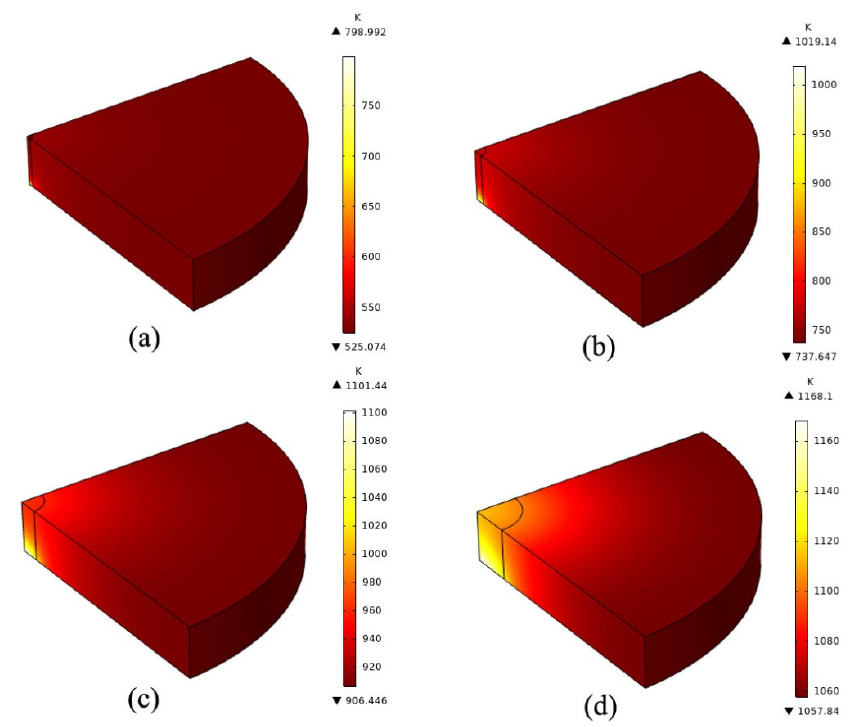
Figure 6. ( a – d ) are the schematic diagram of the temperature change in the center of the silicon wafer when lasers with different beam radii (0.5 mm, 1 mm, 2 mm, 4 mm) are continuously irradiated for 60 s, respectively.